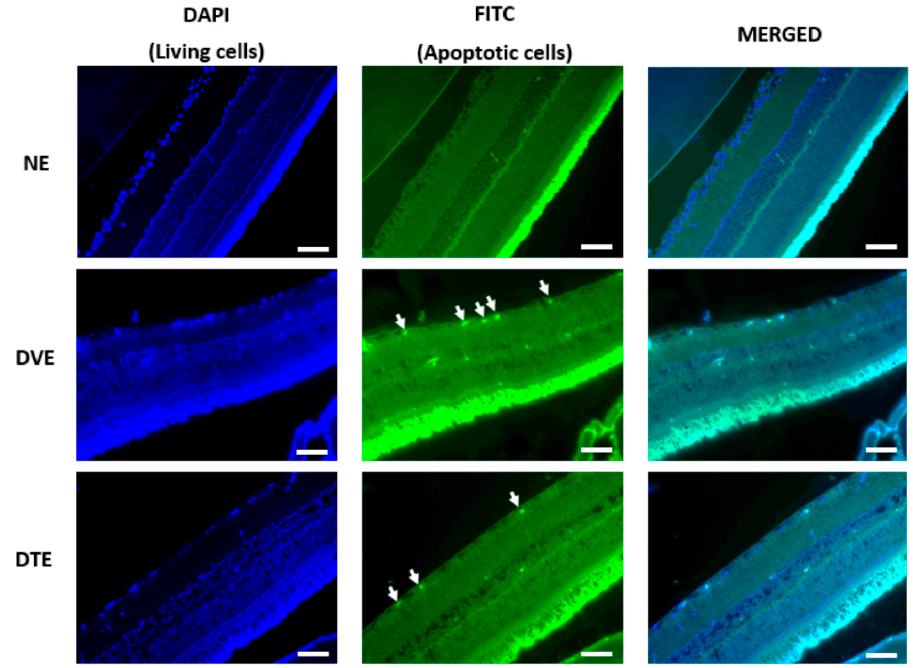
Figure 7. Microphotograph of TUNEL-stained retinal sections, showing the e ff ect of topical TRF on the retinal cell apoptosis (magnification 20 × ). White arrow: TUNEL apoptotic cells, Left: DAPI; Middle: FITC; Right: DAPI + FITC (Merged). NO: Normal rats with oral vehicle treatment, DVO: Diabetic rats with oral vehicle treatment, DTO: Diabetic rats with oral TRF treatment, GCL: Ganglion cell layer. (Scale bar: 100 µ